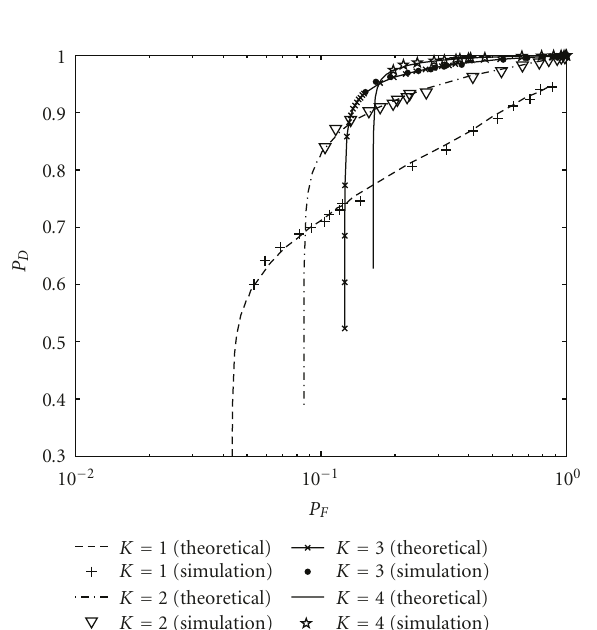
Figure 4: P D versus P F for di ff erent number of sensors assuming Rayleigh fading channels in both links, γ = 10 dB.